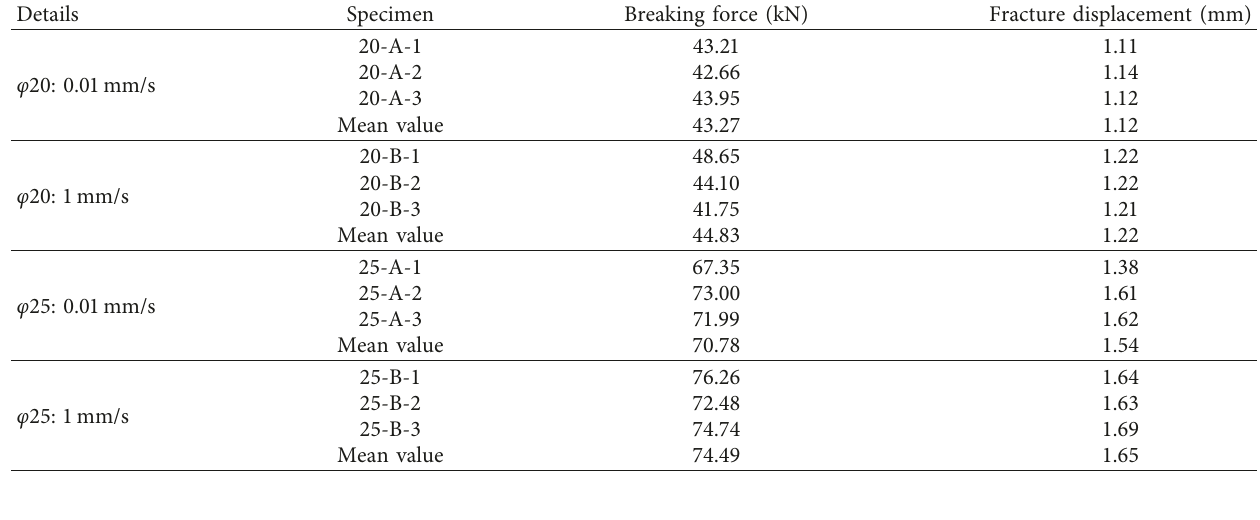
Figure 9: Fracture morphology of the pintles. (a) Sample 20-C-4. (b) Sample 20-C-4. Table 1: Pintle test results.